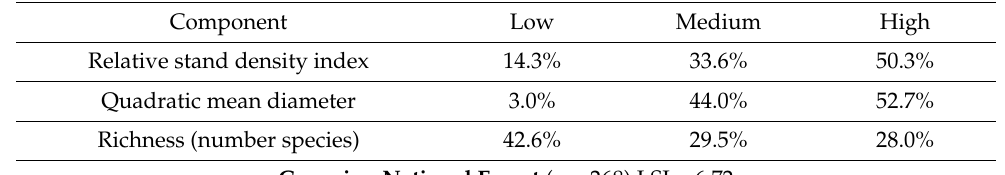
Table 5. Cont . Apache-Sitgreaves National Forest ( n = 336) LSI =